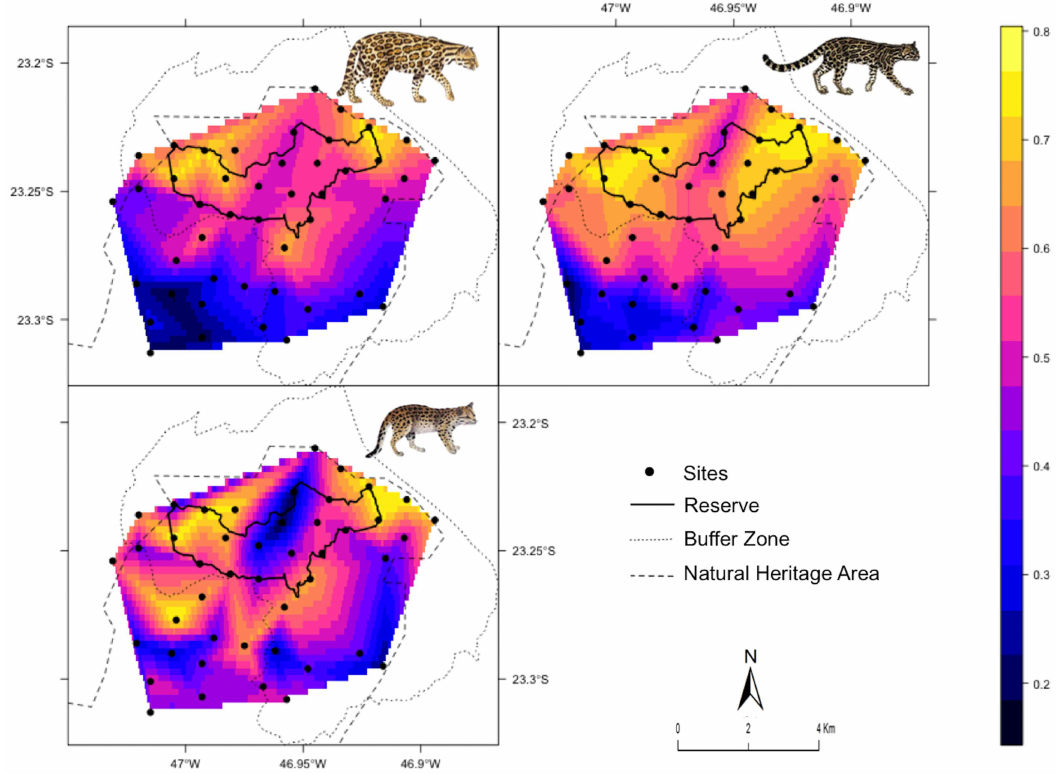
Fig 2. Neotropical spotted cats’ site occupancy. Interpolated site occupancyof the three spotted cats at an Atlantic Forest site in Brazil: ocelot— Leoparduspardalis (top left), margay— L . wiedii (top right), oncilla— L . guttulus (bottom